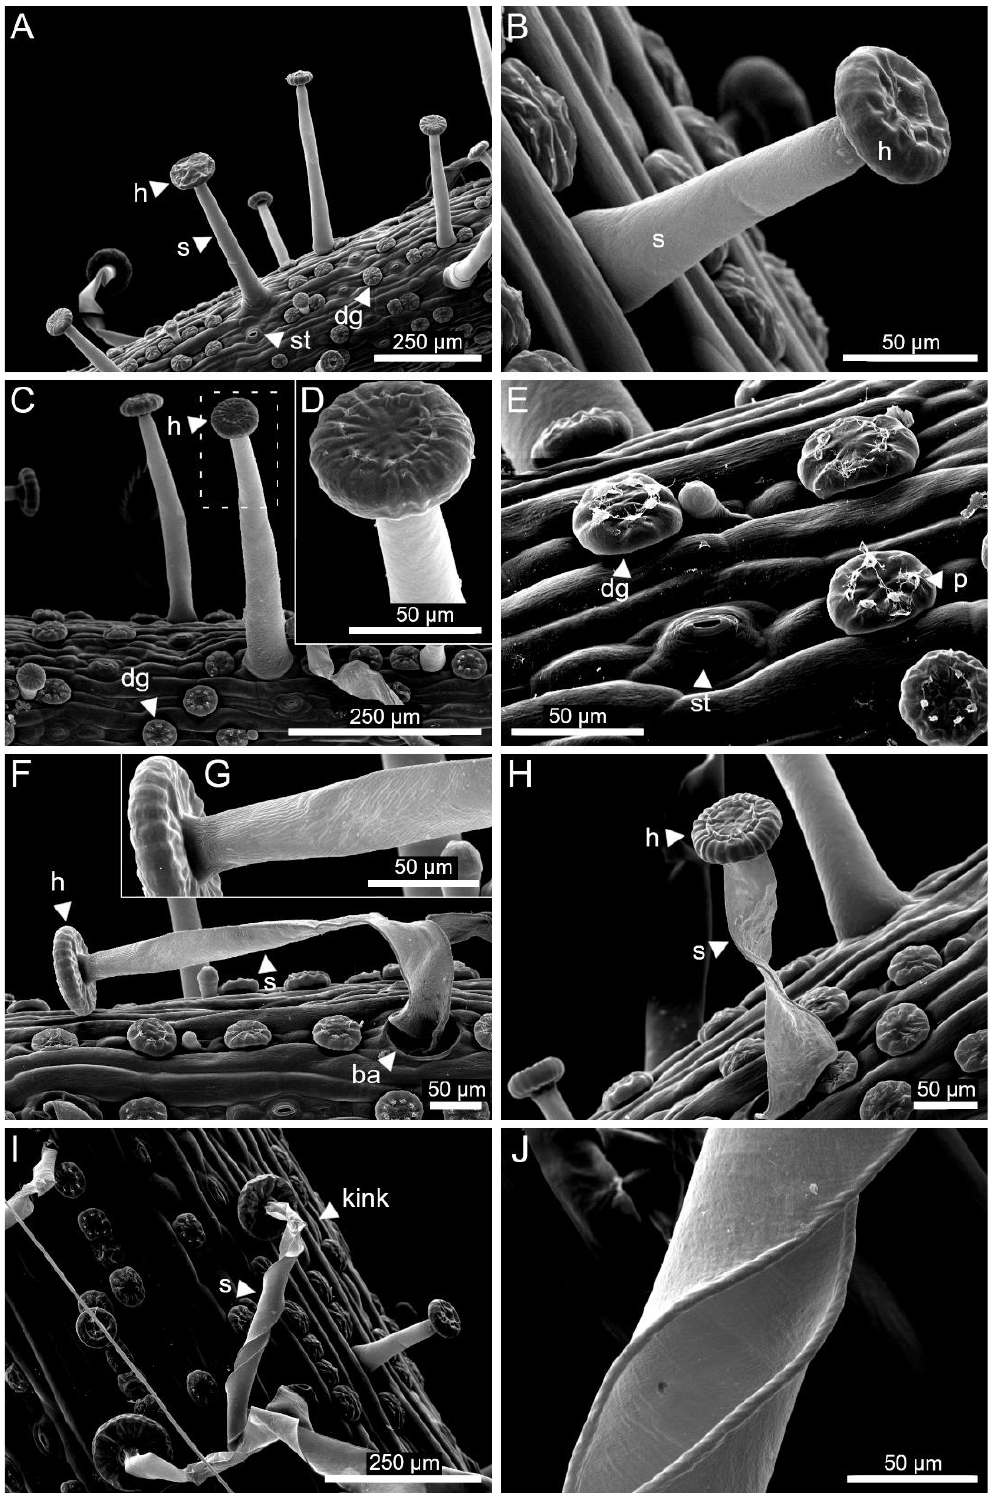
Figure 10. SEM images of critical point-dried B. gigantea leaves with non-stimulated and stimulated stalked glands. ( A – D ) Leaf surfaces with stomata and digestive glands and non-stimulated stalked glands with stalk cells and heads. ( D ) is a detailed view of the stalked gland framed with a dashed white line in ( C ). ( E ) is a detailed view of the leaf surface with stomata and digestive glands. On the digestive glands, pores with mucus residues are visible (thick white arrow). ( F – I ) Leaf surfaces with stimulated stalked glands. The respective stalk cells are flattened from their apical to their basal regions and have kinked and twisted to different degrees. ( G ) is a detailed view of the stalked gland in ( H ). ( J ) is a detailed view of a flattened and twisted stalk cell.